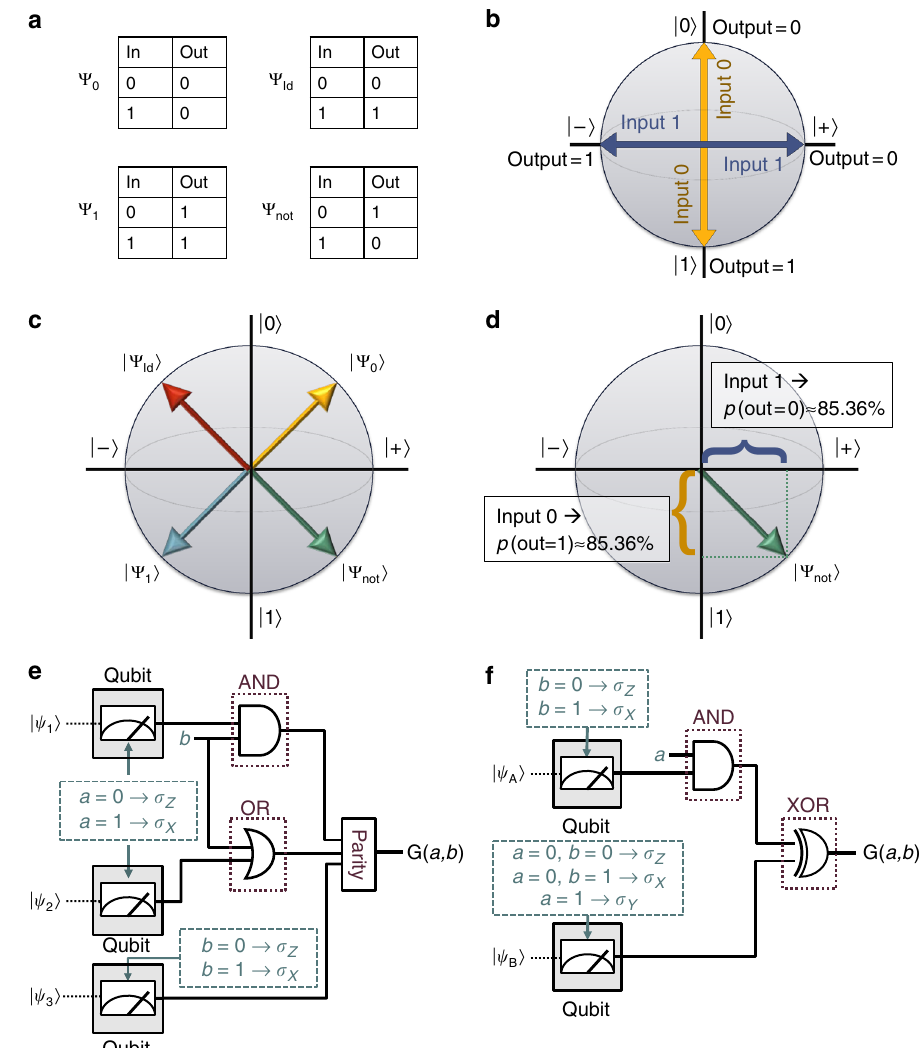
Fig. 2 Method for constructing probabilistic one-time programs for gates with one and two bits of input. All possible truth tables for gates in G 1 are shown in ( a ) while ( b ) shows the encoding of Bob ’ s inputs: a measurement in σ Z corresponds to an input of 0 to the gate while a measurement in σ X corresponds to an input of 1. The output of the gate is given by the measurement outcome. c An overview of the four G 1 states in a Bloch-sphere representation. A detailed example is shown in ( d ): when measured in σ Z (i.e., input 0) the state corresponding to Ψ not will be found in the state |1 〉 , corresponding to an output of 1, with a probability of about 85.36%. When measured in σ X (i.e., input 1) the measurement will fi nd | + 〉 , so an outcome of 0, with the same probability. e , f Two equivalent circuits to build an arbitrary G 2 gate. The ( e ) is based on three G 1 gates while the circuit shown in ( f ) only requires two quantum states per gate, some of which however need to be outside the X – Z